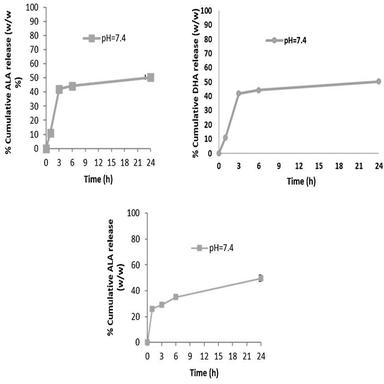
(A) ALA release from xanthan gumbased hydrogel. Data are the mean ± SD of three different experiments. (B) DHA release from xanthan gum-based hydrogel. (C) ALA release from xanthan gum-based microspheres. Data are the mean ± SD of three different experiments. Data are the mean ± SD of three different experiments. Significance was evaluated by the unpaired t-test.